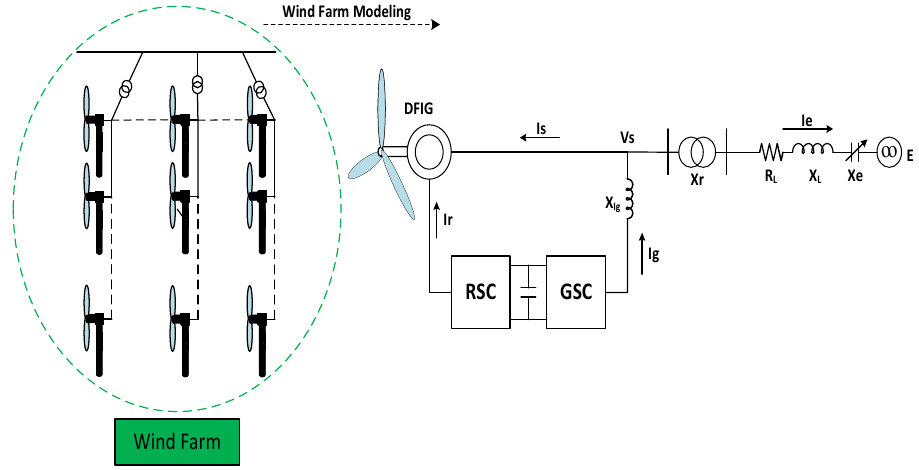
Figure 1. Single Line diagram of a DFIG-based WT.